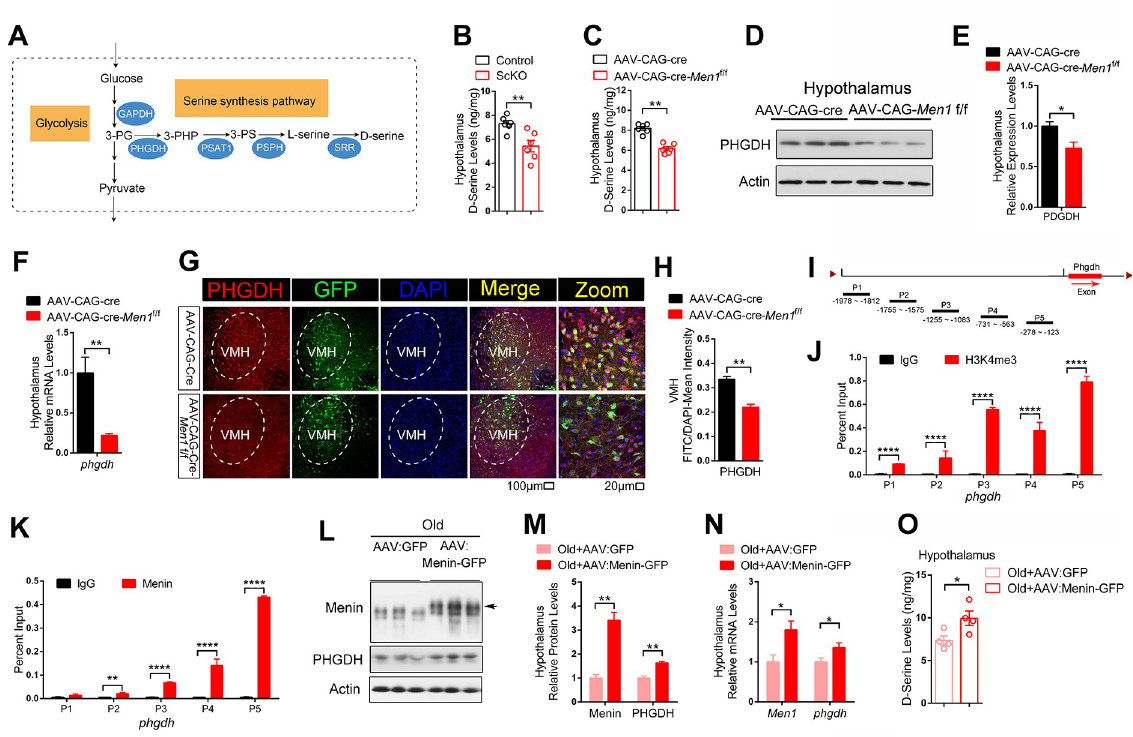
Fig 4. Menin deficiency results in disrupted D-serine synthesis in the hypothalamus. (A) Schematic diagram of D-serine synthesis pathway. (B, C) D-serine levels in lysates of the hypothalamus from 10 months male control and ScKO mice (B), and 10 months male AAV-CAG-Cre and AAV-CAG-Cre- Men1 f/f mice (C) were determined by ELISA; n = 6 mice. (D–F) The protein and mRNA levels of PHGDH in the hypothalamus from 10 months male AAV-CAG-Cre and AAV-CAG-Cre- Men1 f/f mice were measured; n = 3 mice or n = 6 mice, respectively. (G, H) Immunofluorescent staining of PHGDH (red) and GFP (green) in the hypothalamus region from 10 months male AAV-CAG-Cre and AAV-CAG-Cre- Men1 f/f mice. Representative confocal images are shown on panel G. Scale bar, 100 μ m, 20 μ m. Quantitation of fluorescence intensity of PHGDH are showed in panel H; n = 3 mice. (I) Schematic diagram of phgdh promoter region. (J, K) ChIP assays using antibodies against H3K4me3 or Menin were performed in cultured wild-type neurons on DIV 12; n = 3 independent experiments. (L–N) AAV-Menin-GFP virous or control virous AAV-GFP were injected into the hypothalamus region of 20 months male mice (Old+AAV:GFP; Old+AAV:Menin-GFP). The protein and mRNA levels of Menin and PHGDH were measured in the hypothalamus of above mice; n = 3 mice. (O) D-Serine levels in the hypothalamus from 20 months male Old+AAV:GFP and Old+AAV:Menin-GFP mice were determined by ELISA; n = 4 mice. Data represent mean ± SEM, n.s.: not significant, � p < 0.05, �� p < 0.01, ��� p < 0.001, one-way ANOVA with Tukey’s post hoc analysis. The underlying data of Fig 4 can be found in S4 Information. ChIP, chromatin immunoprecipitation; PHGDH, phosphoglycerate